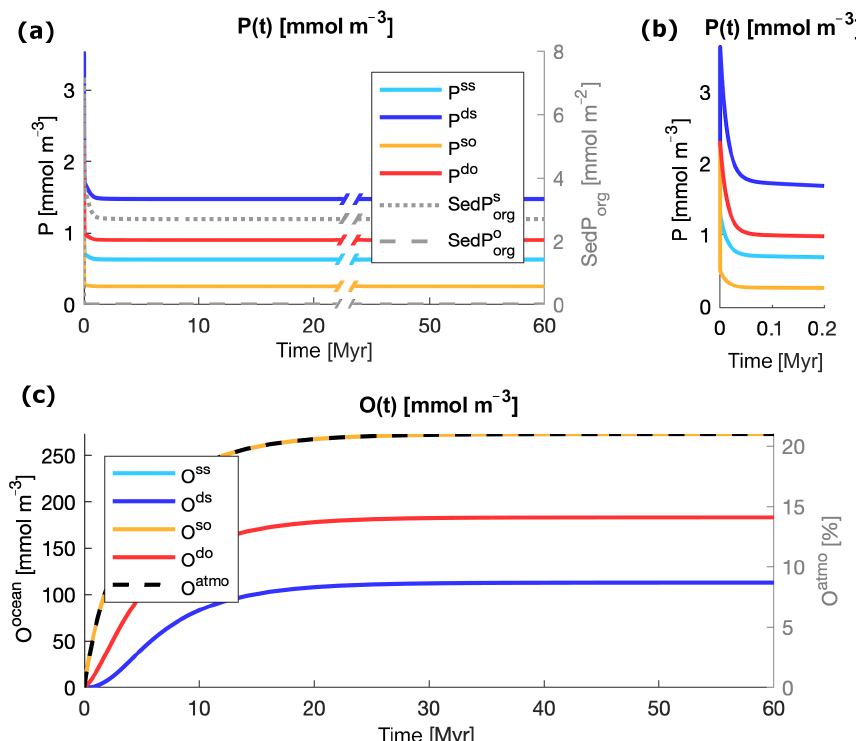
Figure 3. Evolution of the state variables from the initial conditions listed in Table 2 and remineralization lengths roughly in the middle of the interval of explored values, z remS = 20m and z remL = 250m. (a) Evolution of inorganic phosphorus P in the water column (left axis) and of organic phosphorus in the sediments SedP org (right axis). (b) A zoomed-in view of the dynamics of P in the first 200000 years. (c) Evolution of oxygen in the water column (left axis) and atmosphere (right axis). In (c) the two lines O ss and O so are overlapping; the two variables evolve closely due to the coupling of the surface ocean with the atmosphere via air–sea gas exchange.